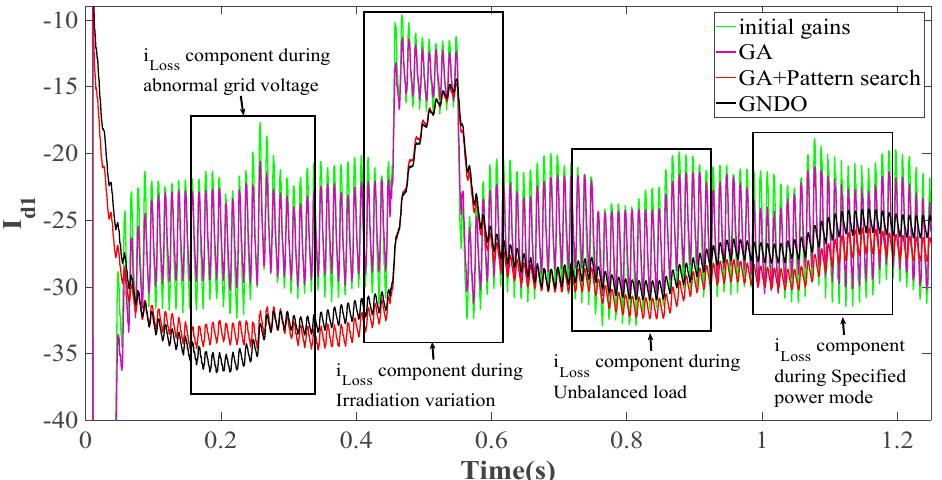
Figure 21. Loss component of current with GA, GA with pattern search and GNDO tuned PI controller gains.